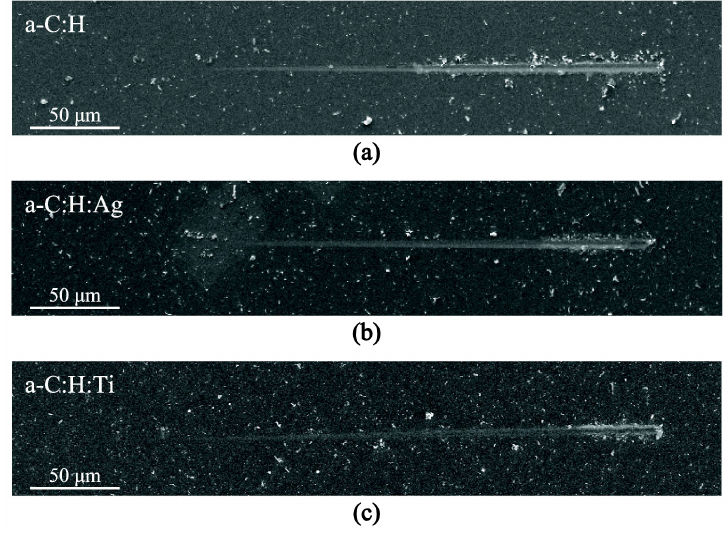
Figure 10. Characteristic residual scratches on ( a ) a–C:H, ( b ) a–C:H:Ag and ( c ) a–C:H:Ti